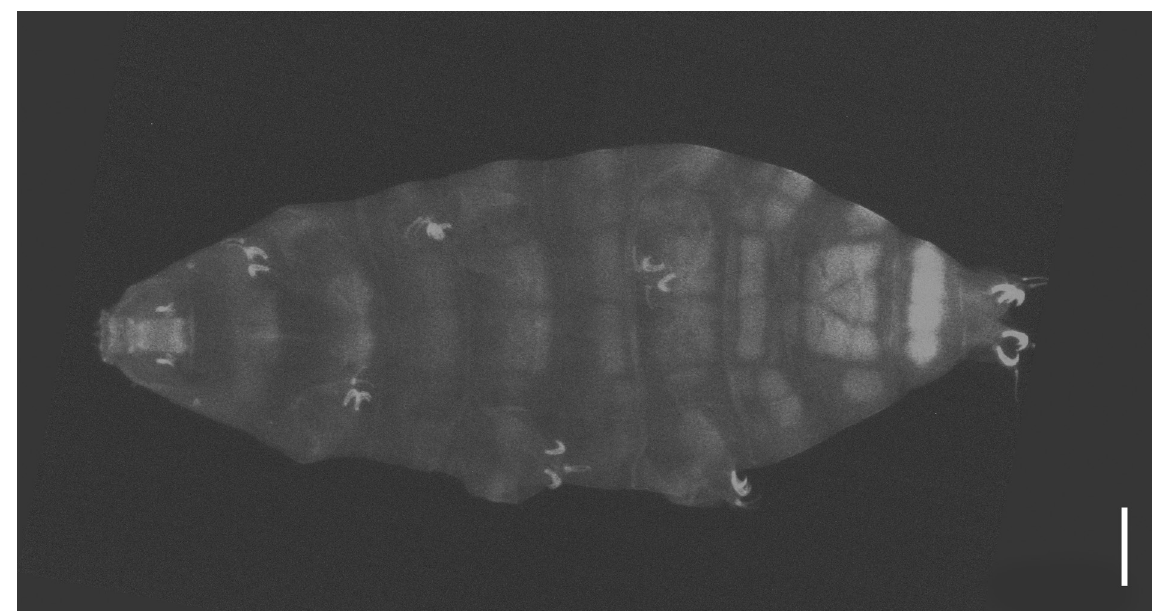
Fig. 9. Milnesium pelufforum sp. nov., holotype, ♀ (slide No. MCNS tar. 000021-3), under UV fluorescence microscope, showing various pseudoplates. Scale bar = 50 µm.